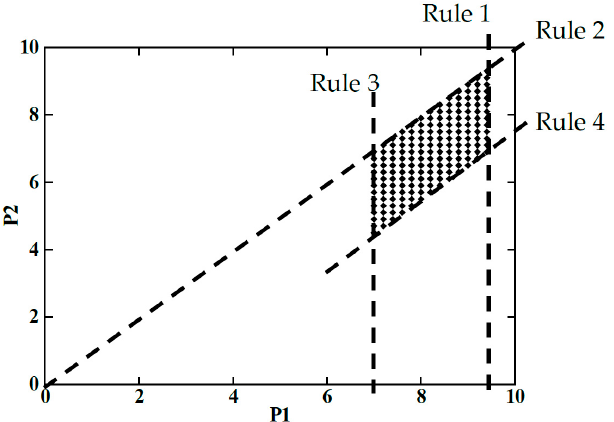
Figure 8. Search space pruning in example 1.